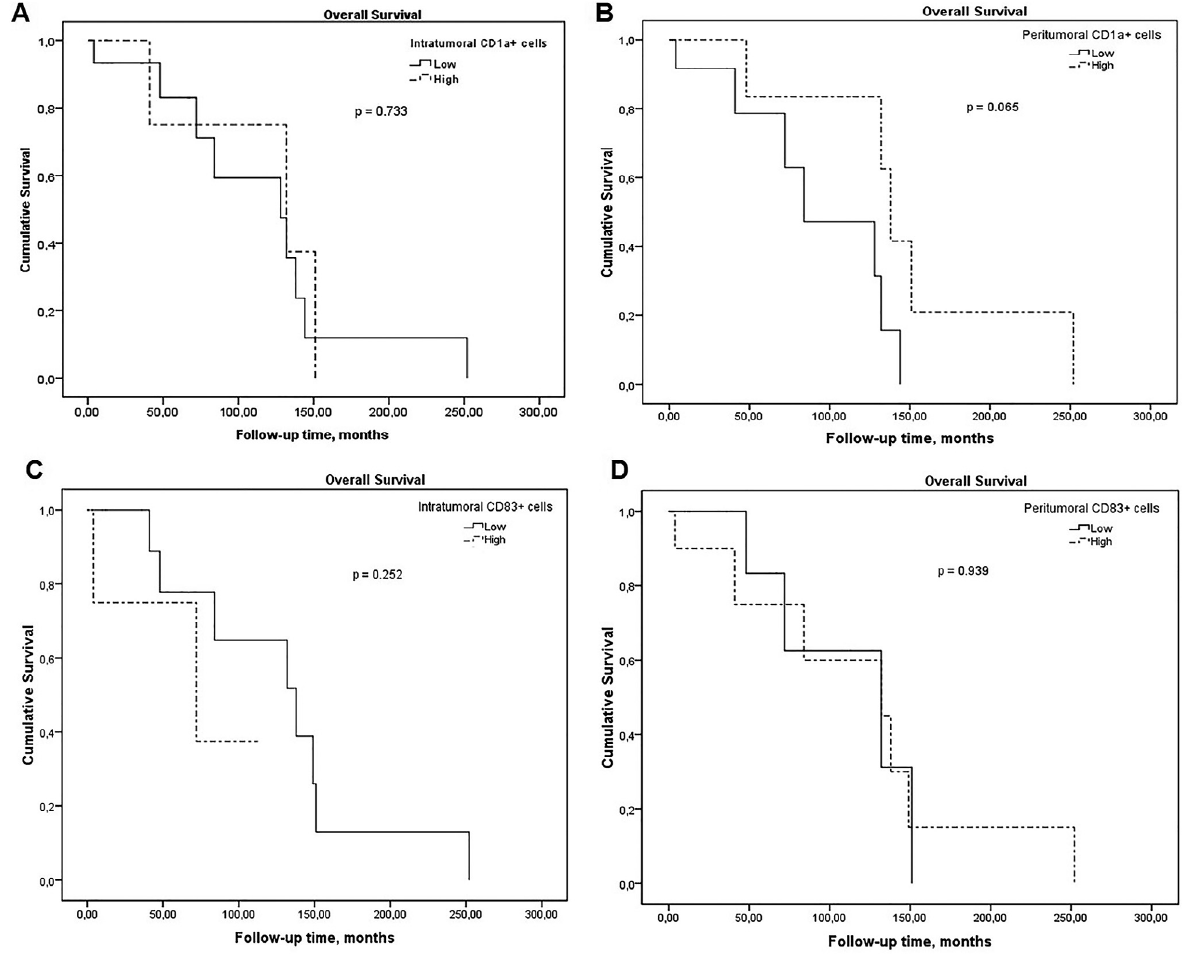
Figure 2- Kaplan-Meier plots of overall survival in months after initial diagnosis for patients with tonsillar squamous cell carcinoma. Stratification for (A) intratumoral CD1a+ cells; (B) peritumoral CD1a+ cells; (C) intratumoral CD83+ cells; and (D) peritumoral CD83+